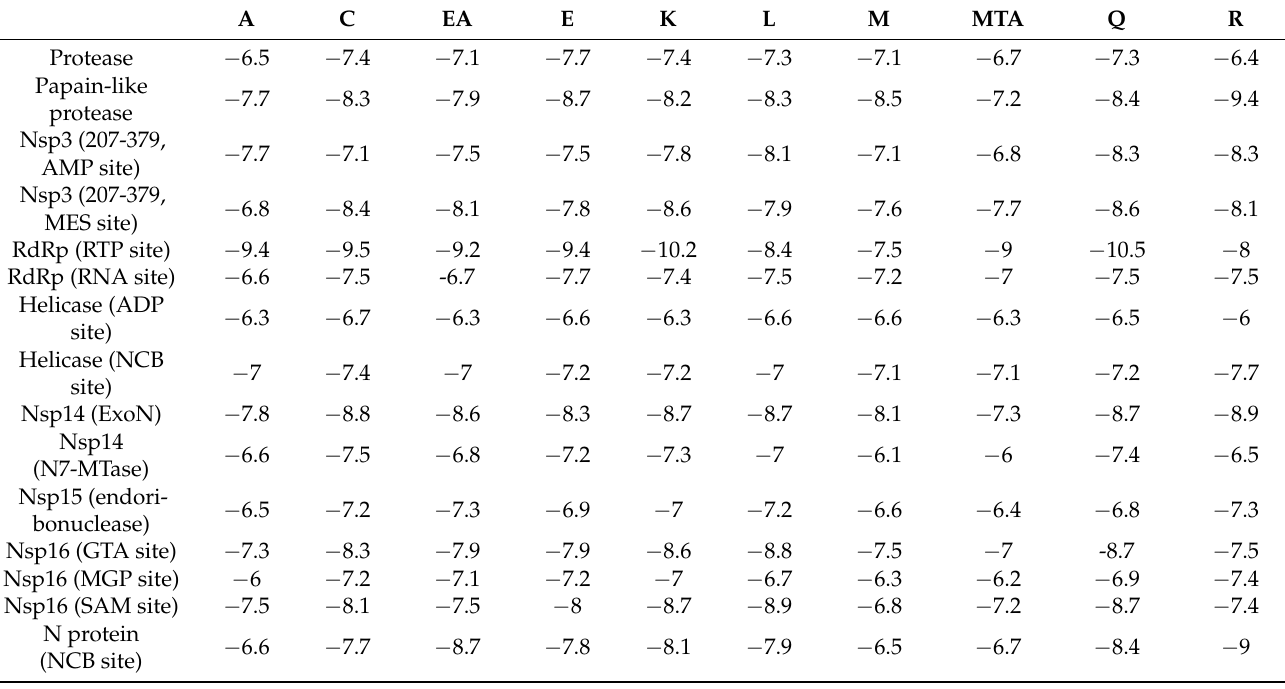
Table 1. Docking results for leader compounds against the main targets of SARS-CoV-2. Protease, papain-like